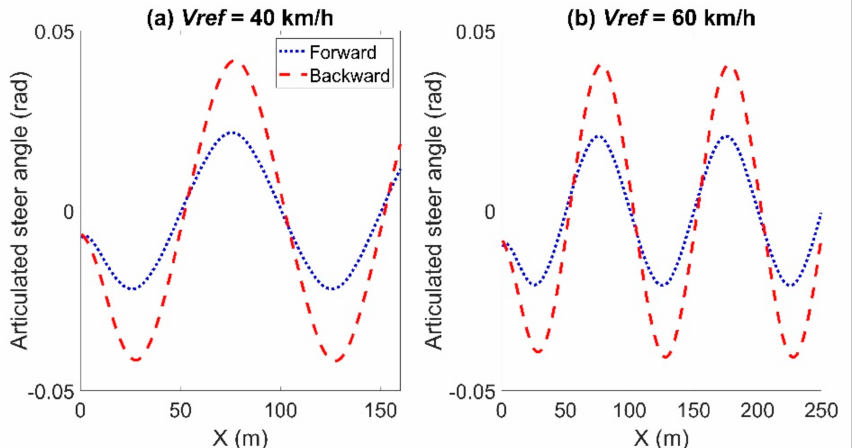
Figure 7. Articulated steer angle for the comparison between the forward and backward Euler method: left for Case ( a ) with Vref = 40 km/h and right for Case ( b ) with Vref = 60